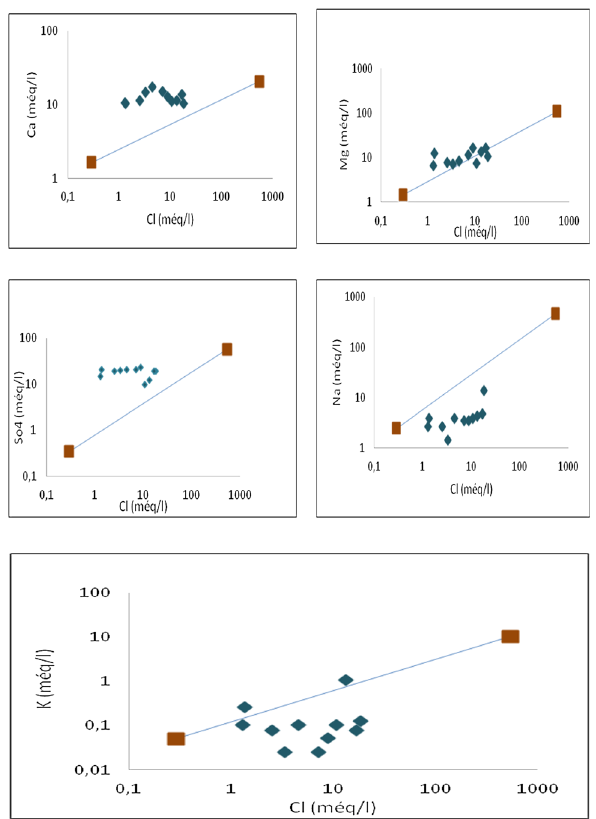
Fig. 6 Concentration variation of major elements according to chlo- ride of El Ouldja valley springs waters